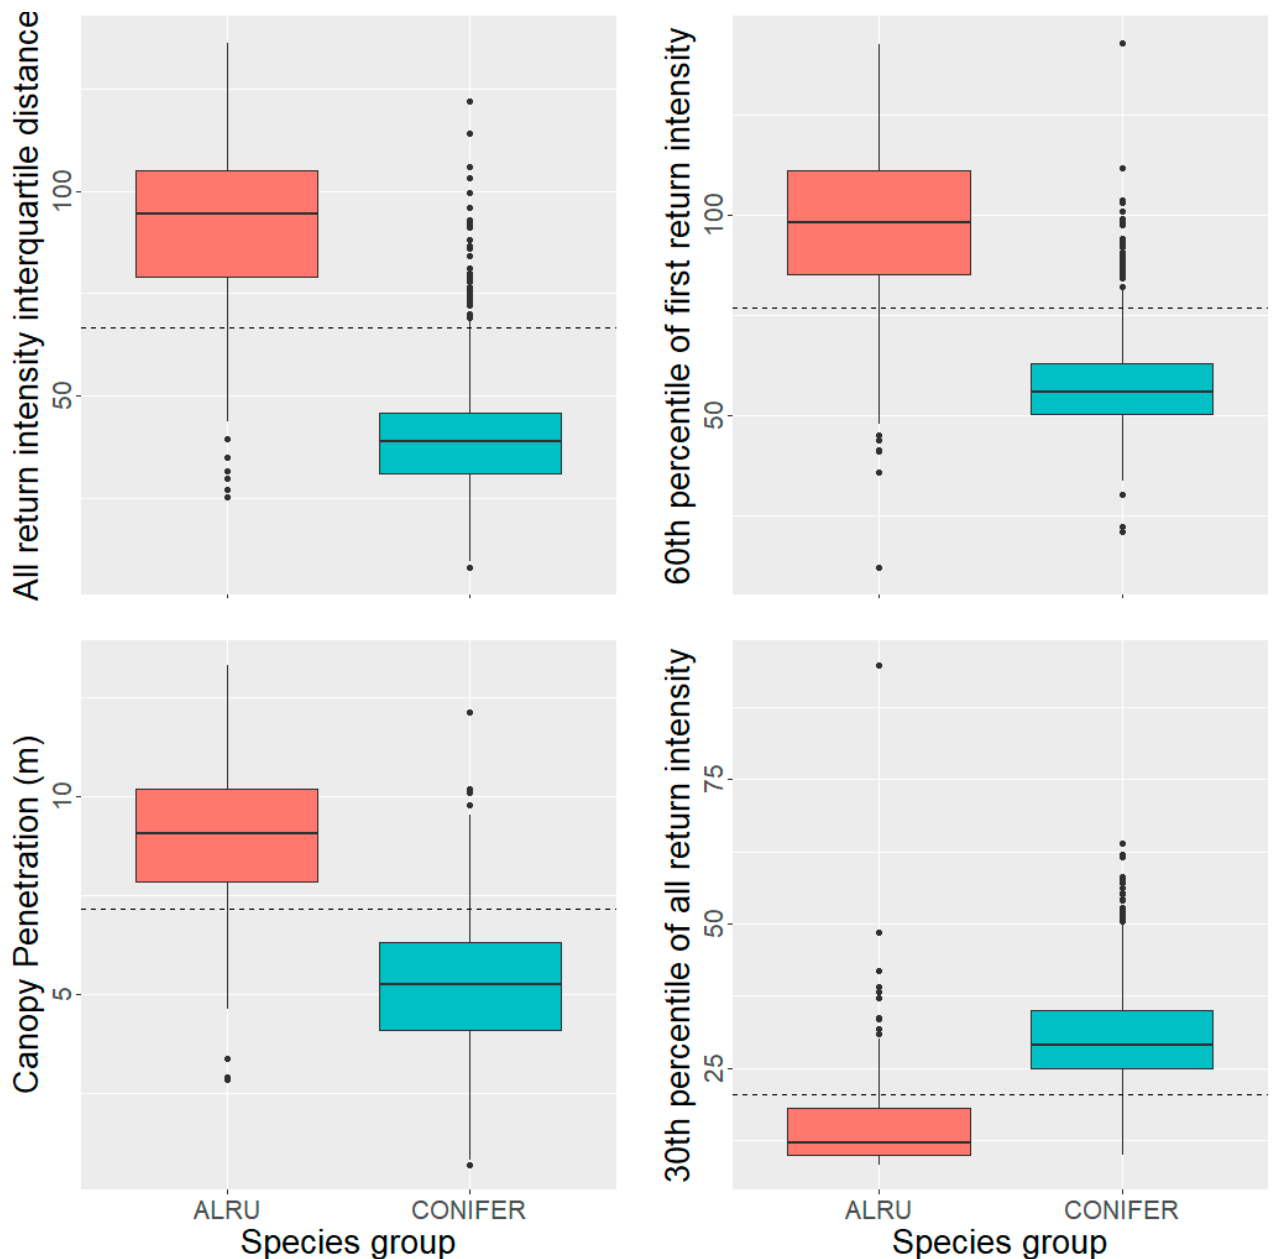
Figure 6. Box plots for the four variables used in the final random forest classification model. Dashed horizontal lines are the threshold values used for the simple threshold models. We applied the classification model using LiDAR metrics computed for a 1.524 m by 1.524 m raster over an area of about 3025 ha. Figure 7 shows one of the tree plots overlaid on the classification results. In general, the classification results match the areas represented by the circular crown images for red alder shown in Figure 7. In areas dominated by red alder, the classification results present contiguous patches of red alder. However, in areas with a mix of red alder and conifer species, results are somewhat broken but still correspond well to the known locations of red alder. Figure 8 shows the classification results overlaid on the entire Sappho LTEP study area. For treatment units known to contain high proportions of red alder, the results also indicate high proportions of red alder. In addition, riparian areas (upper left corner in Figure 8) contain stands dominated by red alder with a few